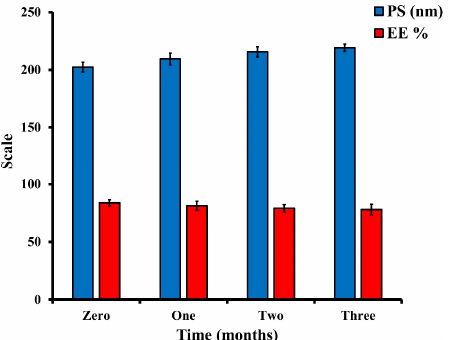
Figure 6. Particle size and entrapment efficiency analysis of the optimized BER-CTS-BLS preparation during three months of storage (4 ◦